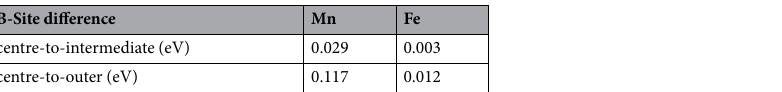
Table 3. Energy difference variation between centre-to-intermediate and centre-to-outer B6TFMO B-sites for Mn and